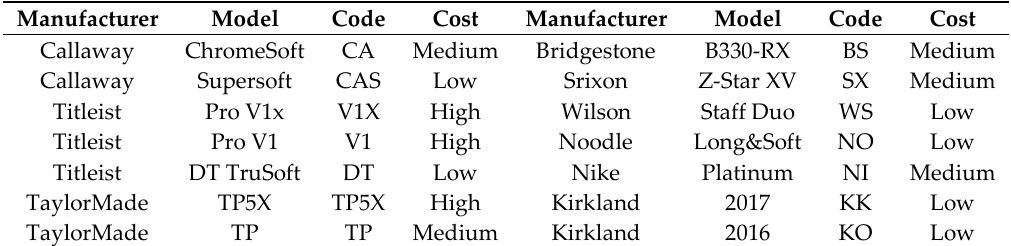
Table 1. Description of the golf balls considered in this